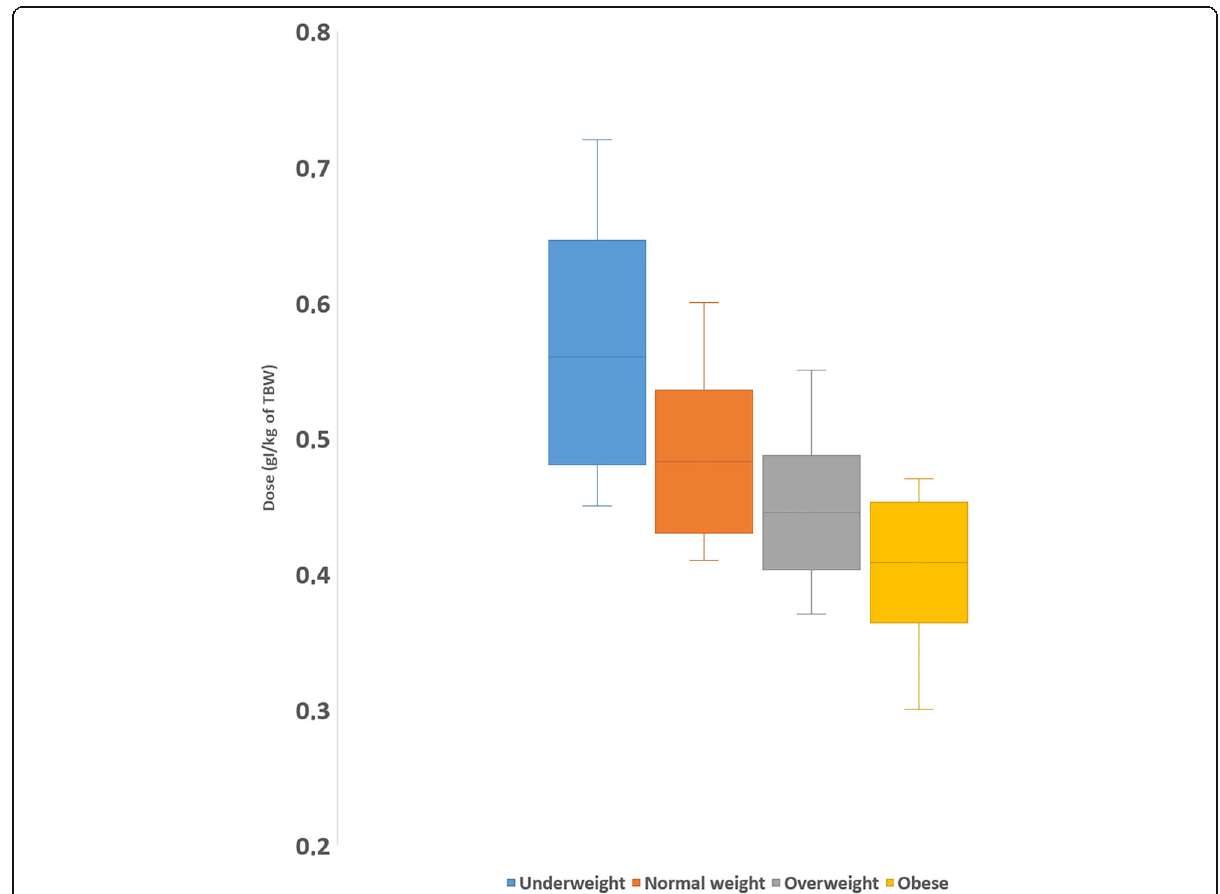
Fig. 1 Box plot showing the mean CA dose (in grams of iodine per kilogram of total body weight) per each of the 4 subgroups of the body mass index (BMI) according the WHO (centre line). Mean ± standard deviation (box) and the minimum and the maximum values are also showed (outer